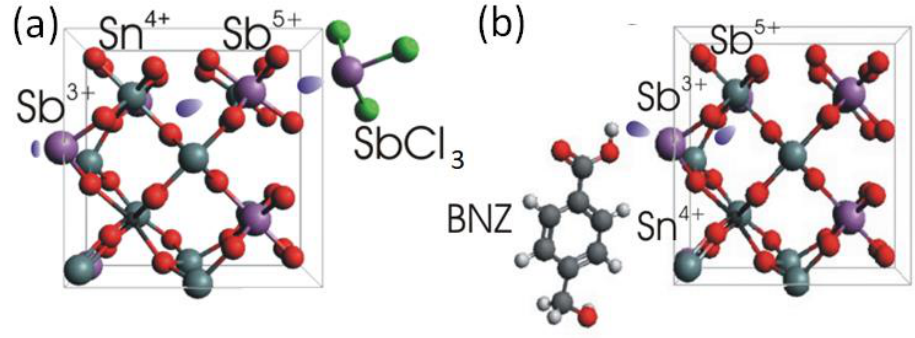
Figure 4. Sketches of the charge transfer via typical donating and accepting ligands attached to the ATO NC surfaces: optimized geometry of ( a ) SbCl 3 and ( b ) BNZ ligands in the stick-ball model and tentative electron density transfers.